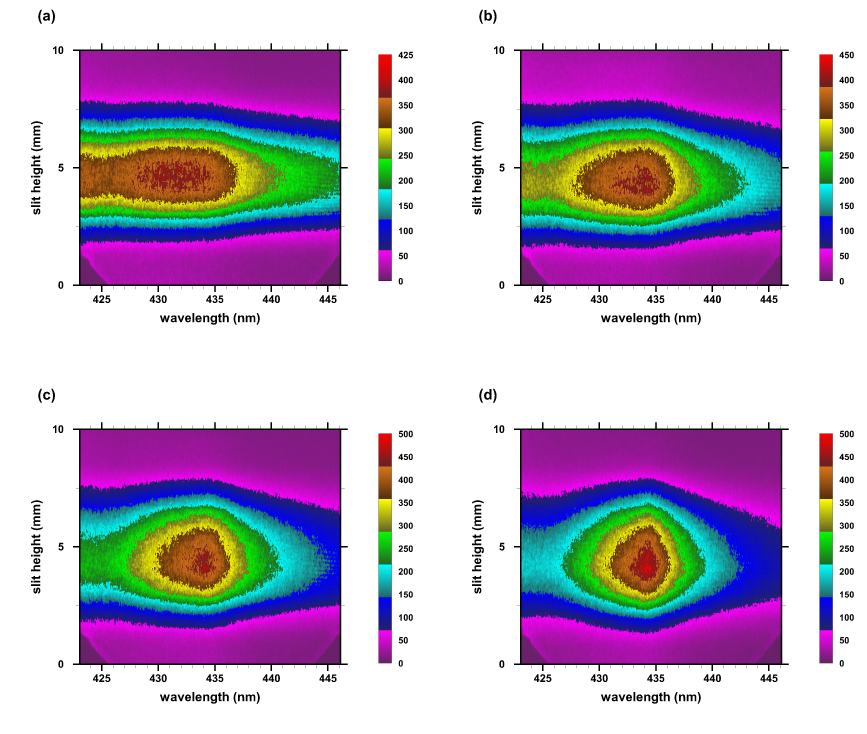
Figure 2. Recorded H γ spectra along the slit for time delay of: ( a ) 100 ns; ( b ) 150 ns; ( c ) 200 ns; and ( d ) 275 ns.